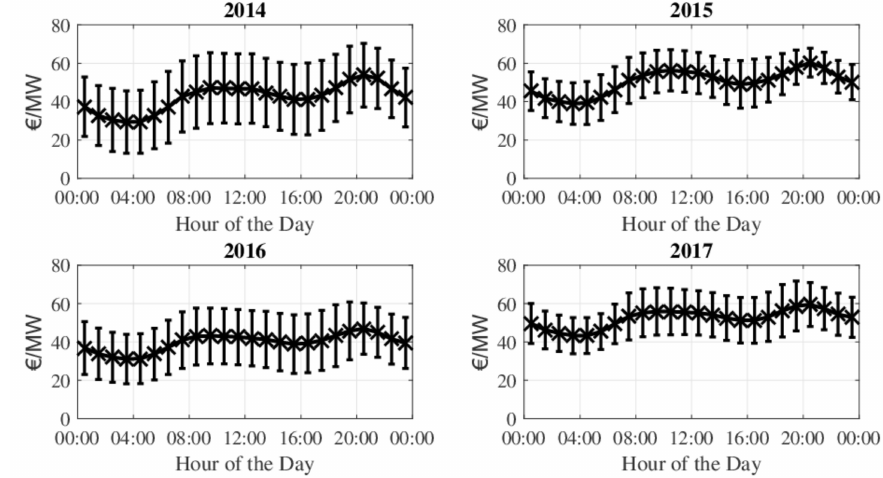
Figure 11. Mean hourly Spanish market price with standard deviation for the years 2014 to 2017